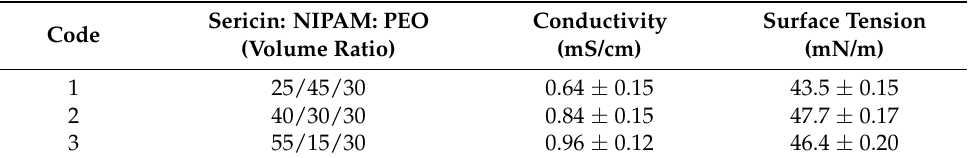
Table 2. The conductivity and surface tension of the interpenetrating network blending spinning solution.